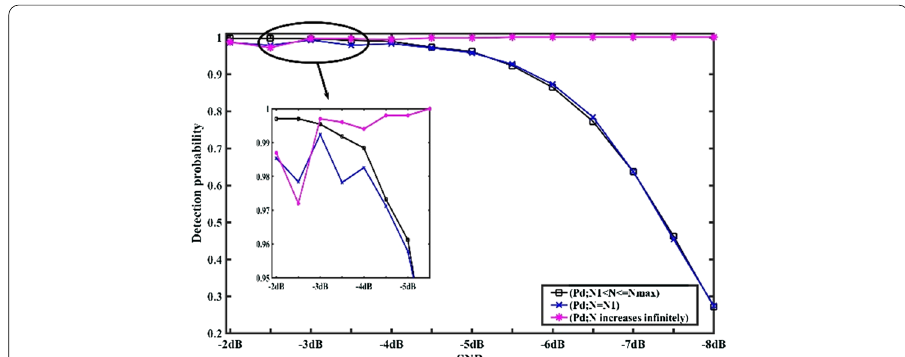
Fig. 6 Detection probability comparisons when false alarm probability is 0.1